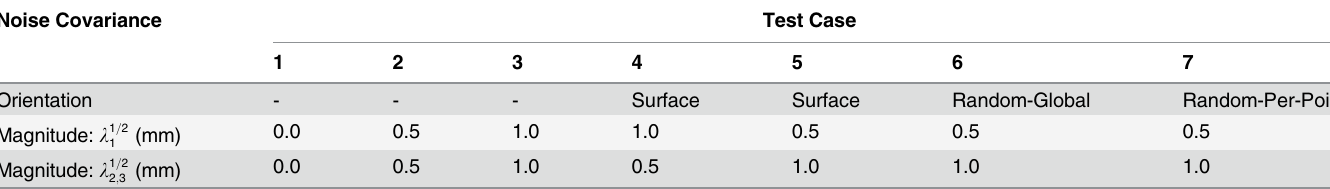
Table 11. Generative noise models (test cases) used in the randomized registration trials of Experiment 6. Noise Covariance